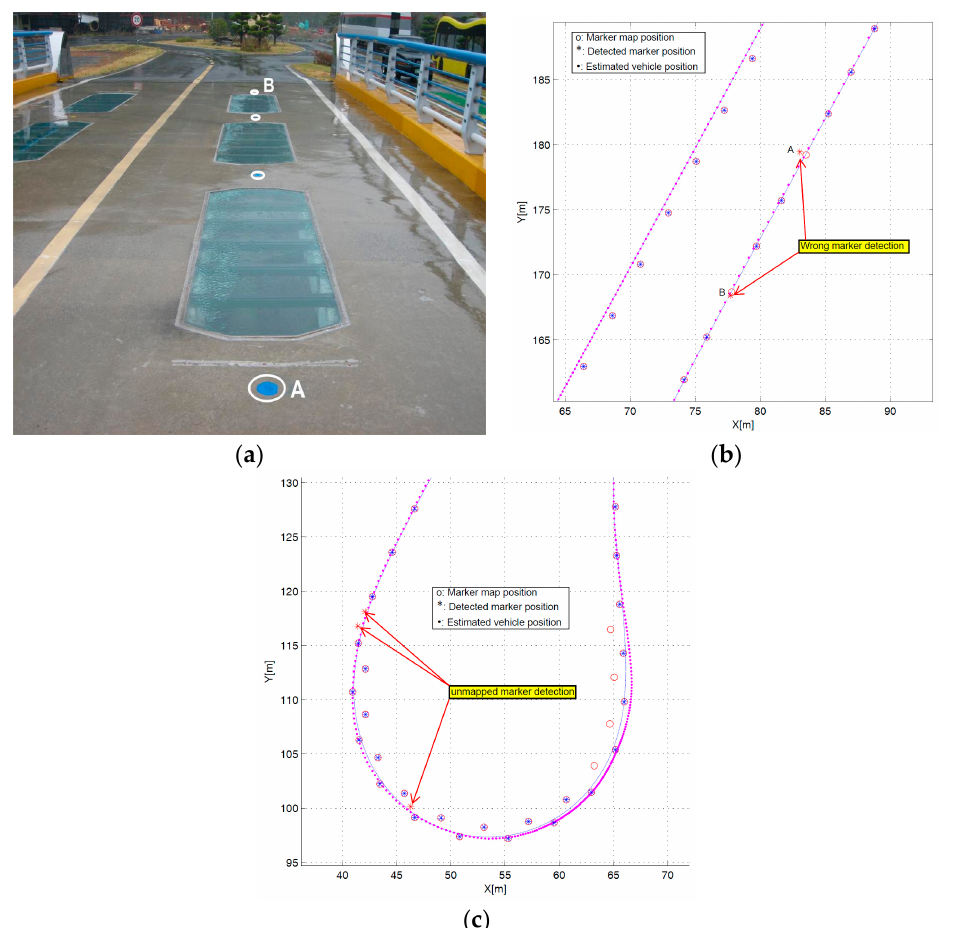
Figure 12. Marker detection and position estimation. ( a ) Magnetic markers on the bridge; ( b ) Marker detection fails on the bridge; ( c ) Unmapped marker detection in the curved section.